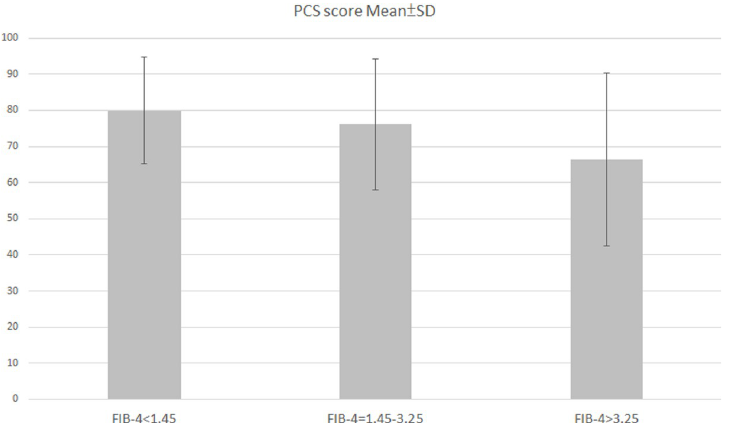
Fig 3. The correlation between PCS scores and FIB-4